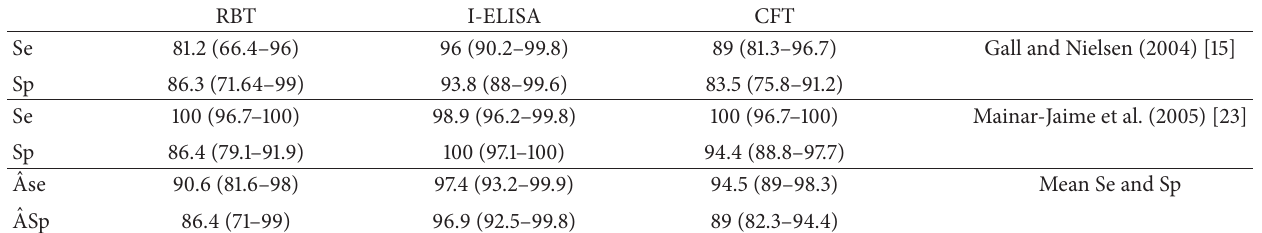
Table 1: Prior information used for sensitivity and specificity of RBT, I-ELISA, and CFT.